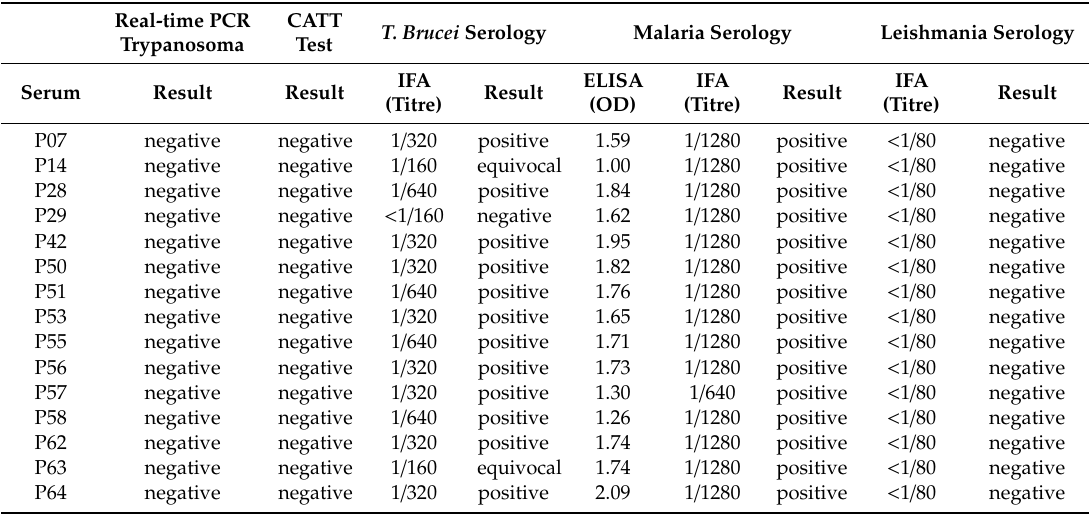
Table 4. Real-time PCR, CATT, T. brucei , Malaria, and Leishmania serology of 15 follow-up patients. Real-time PCR CATT Trypanosoma